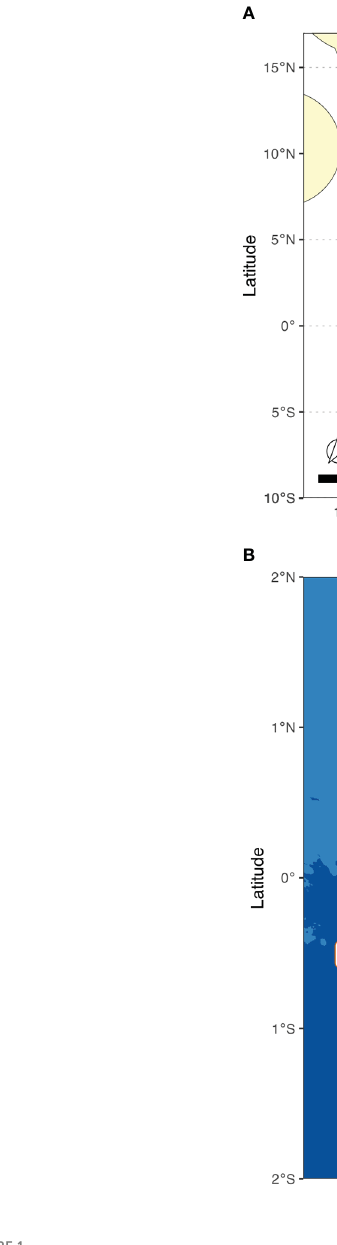
FIGURE 1 (A) Regional map showing the location of the Gala ́ pagos Islands in the eastern tropical Paci fi c, and the boundaries of the Gala ́ pagos Marine Reserve (GMR) and Hermandad Marine Reserve (HMR). The Exclusive Economic Zones (EEZ) of countries bordering the region are shown in yellow. (B) Map of the main islands of the Gala ́ pagos Archipelago (labeled) and bathymetry of the surrounding sea fl oor. The GMR and HMR boundaries are available from Fundacio ́ n Charles Darwin ’ s GeoData Portal at https://geodata-fcdgps.opendata.arcgis.com/. EEZ boundaries are available from Flanders Marine Institute (2019), used under Creative Commons license CC BY. Bathymetry data from SRTM15+ (Tozer et al., 2019), available from https://topex.ucsd.edu/WWW_